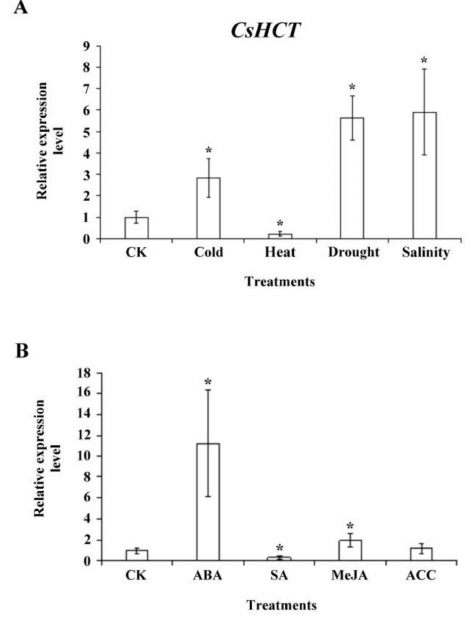
Figure 6. CsHCT expression levels under various abiotic stress and phytohormone